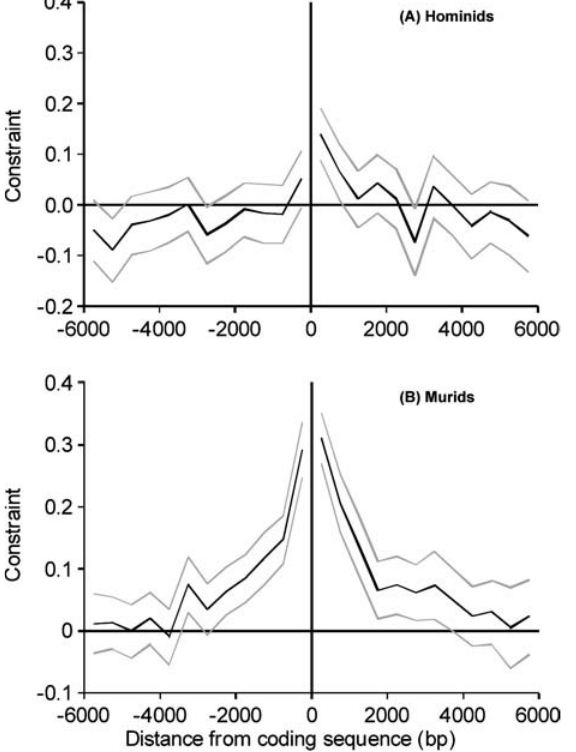
Figure 1. Selective Constraint Plotted against Distance from the Coding Sequence in 5 9 Flanking Regions and 3 9 Flanking Regions Results for (A) hominids and (B) murids. The 5 9 flanking regions are shown left of the origin, and 3 9 flanking regions, right. Segments of 500 bases starting from the start or stop codon were analyzed. Bootstrap 95% confidence limits are shown in light grey. DOI: 10.1371/journal.pbio.0030042.g001